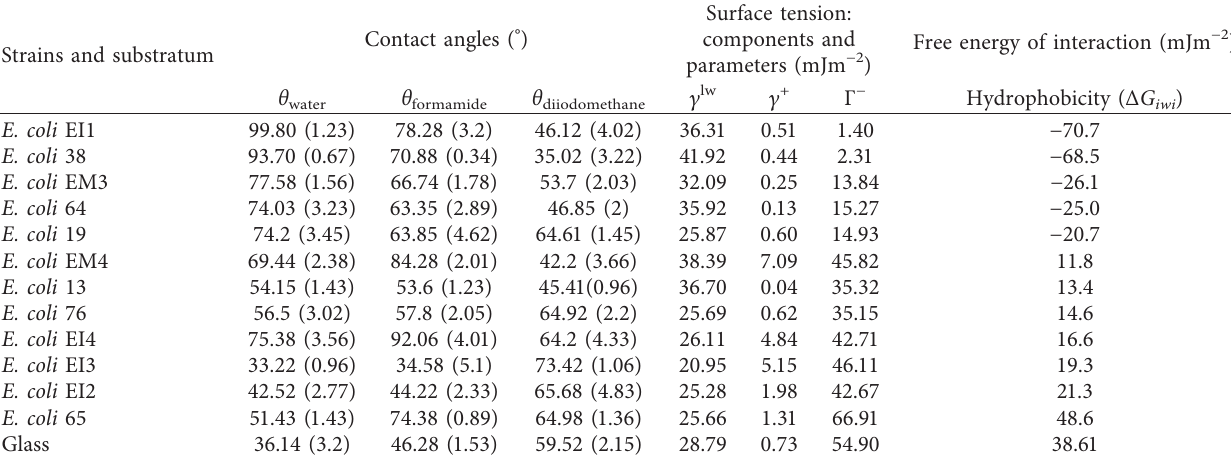
Table 2: Contact angles, surface tension parameters, and free energy of interaction of E. coli strains and glass surface. Strains and